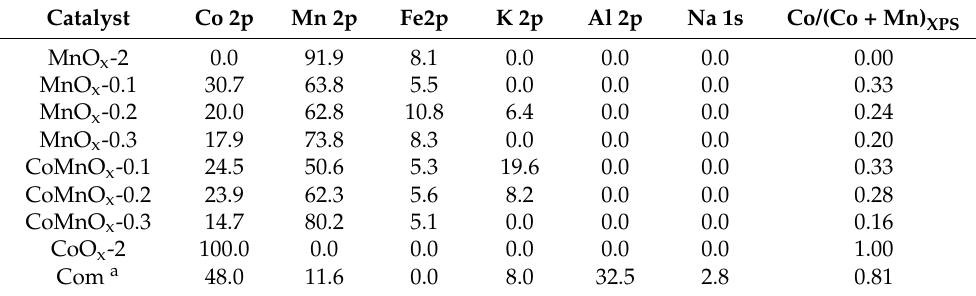
Table 4. Surface composition of the catalysts (at. %) determined by X-ray photoelectron spectrometry (without carbon and oxygen components).